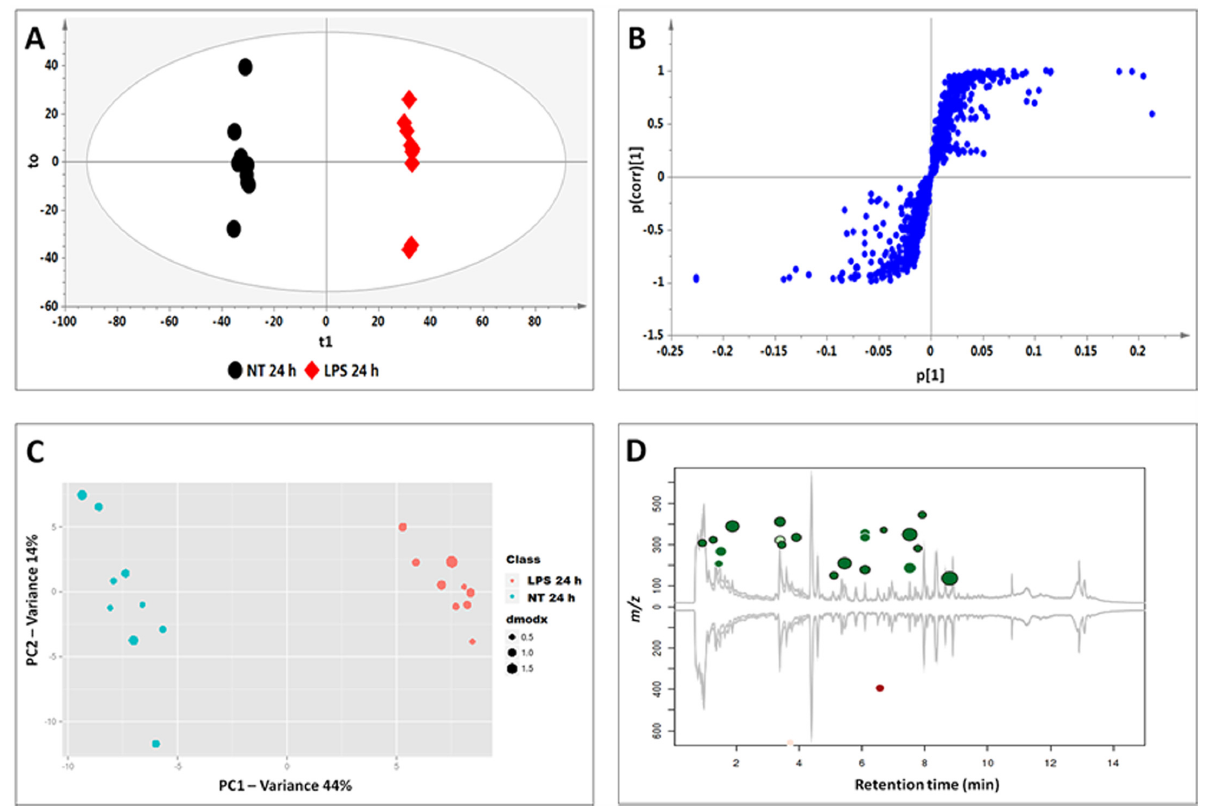
Fig 3. OPLS-DA (A and B) and XCMS (C and D) comparing the 24 h LPS-treated vs. 24 h non-treated cells. (A) The OPLS-DA scores plot and (B) the corresponding S-plot show the different clustering of treated and non-treated samples. The ellipse represents Hoteling ’ s T2 at 95% confidence interval and the model calculated PCs and gave R 2 X = 45.5%, R 2 Y = 99.7% and Q (cum) = 98.5%. Model validation by CV-ANOVA showed high model significance with p value = 1.22 ×10 − 11 . (C) The XCMA PCA scores plot of treated vs. non-treated cells processed by using unit variance scaling centered based on features intensity. (D) The Cloud plot of treated vs. non-treated cells showing data set of 35 features with p -value (cid:3) 0.01 and fold change (cid:1)